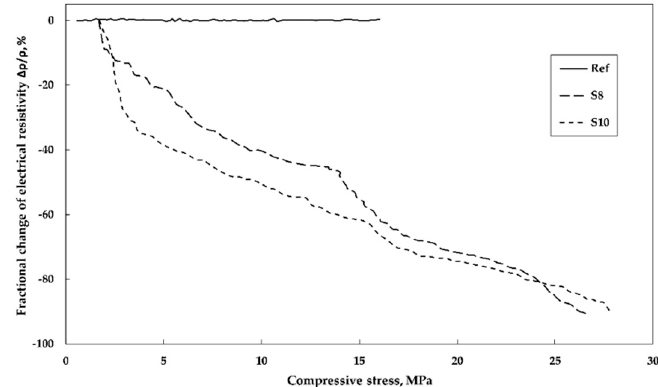
Figure 12. Relationship between fractional change in electrical resistivity and compressive stress.